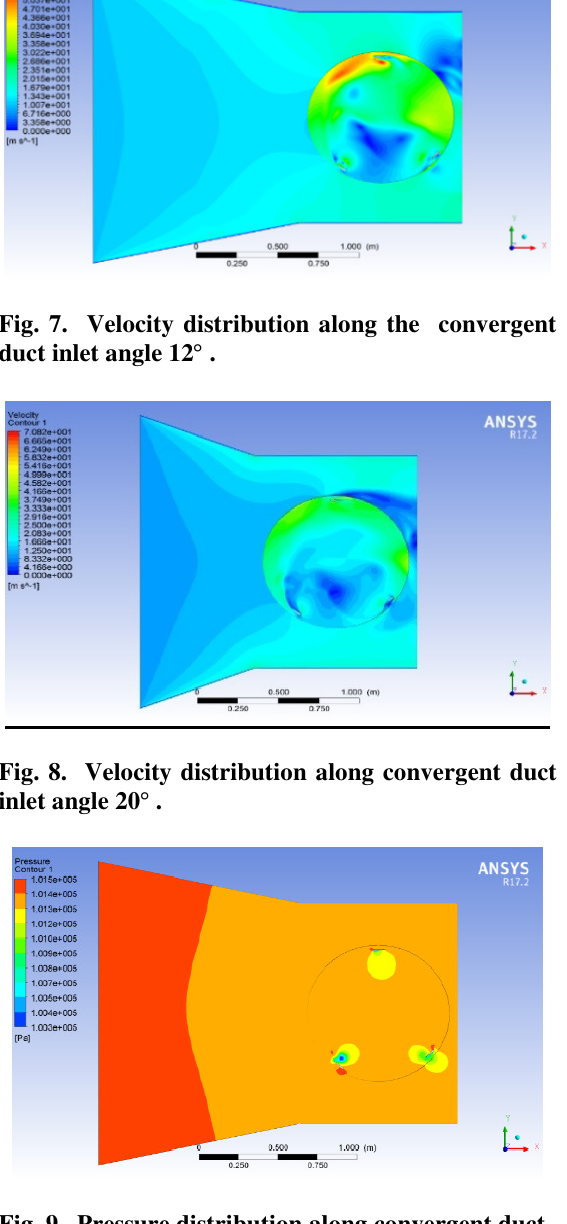
Fig. 13. Power coefficient for convergent duct wind turbine with inlet angle 20